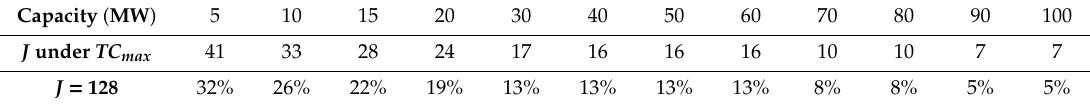
Figure 4. Comparison between mean ATCUj , mean ATCU j of the ten best strategic locations and TC max of the base case scenario. Table 3. Number of strategic locations ( J ) performing under TC max of the base case scenario.